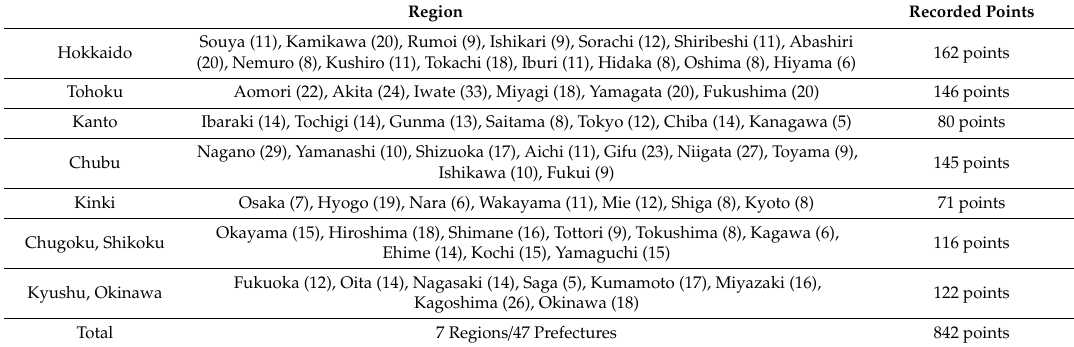
Table 2. Recording points of weather data by region / prefecture.